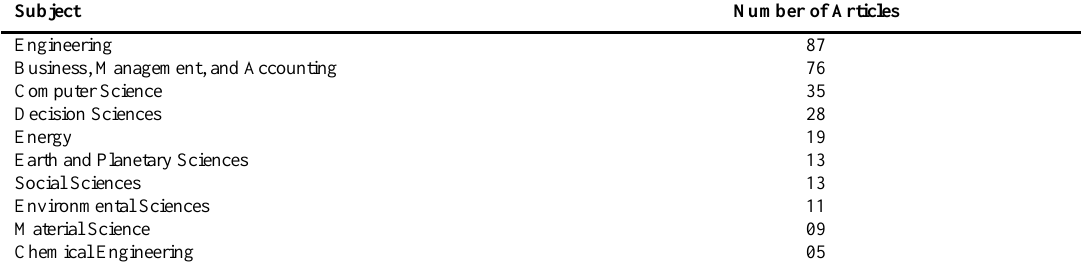
Table 6. Subject-wise publications: intellectual capital and operational